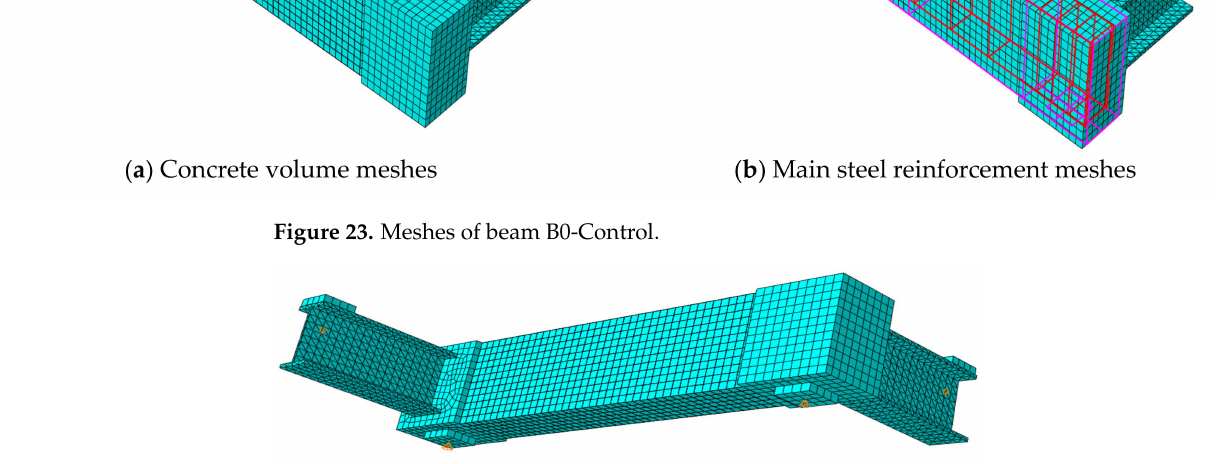
Figure 24. Applied loads and supports.